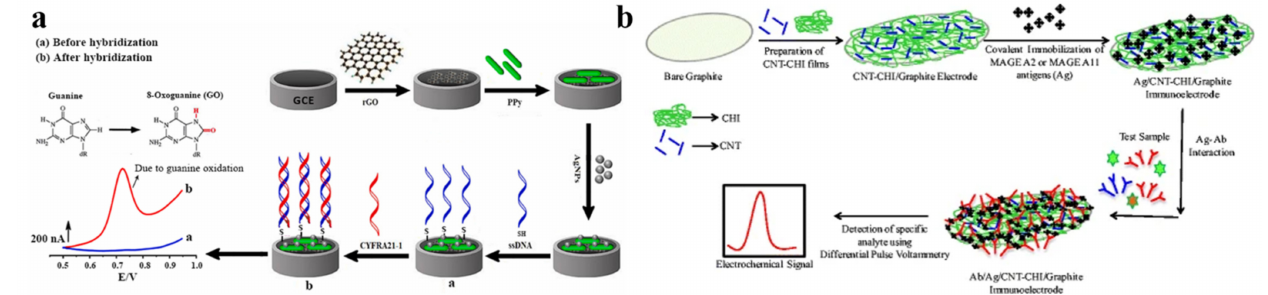
Figure 7. Schematic illustration of electrochemical biosensors fabricated with carbon nanomaterials for detection of lung cancer: ( a ) biosensor fabricated with reduced-graphene oxide together with poly pyrrole, silver nanoparticles and single-strand DNA for identifying lung cancer biomarker, CYFRA21- 1 [24]; ( b ) biosensor fabricated with CNT-CHI composite for identifying lung cancer biomarkers, anti-MAGE A2 and anti-MAGE A11 [51]. ( a ) Reproduced with permission Copyright 2022, Elsevier B.V. ( b ) Reproduced with permission Copyright 2014, Springer-Verlag Wien.